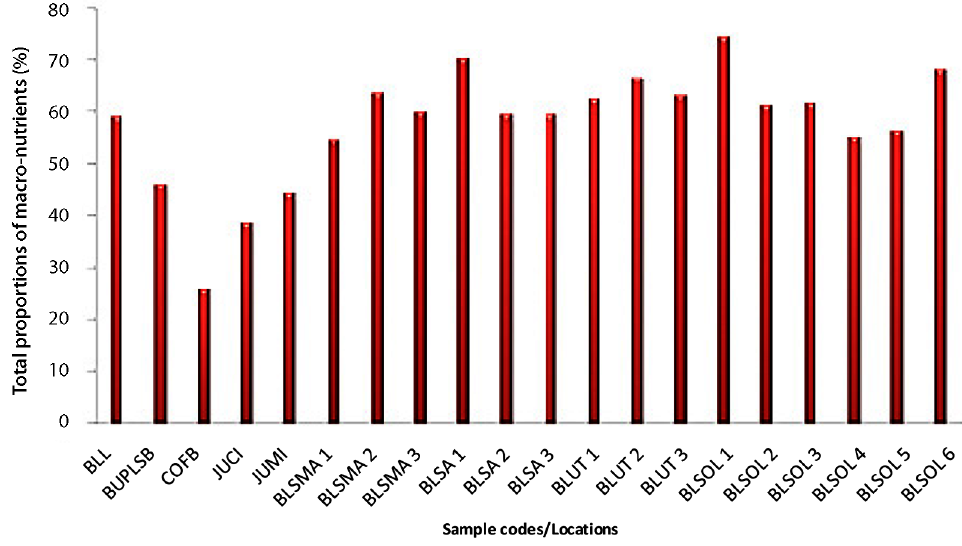
Figure 4. Combined concentrations of macro-nutrients (% by weight) in ignited plant tissues